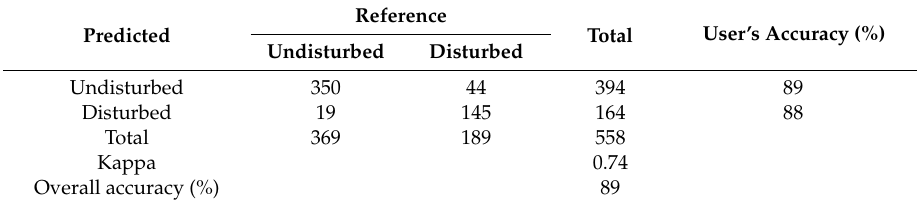
Table 7. Aggregated confusion matrix of forest disturbance classifications for the four districts.